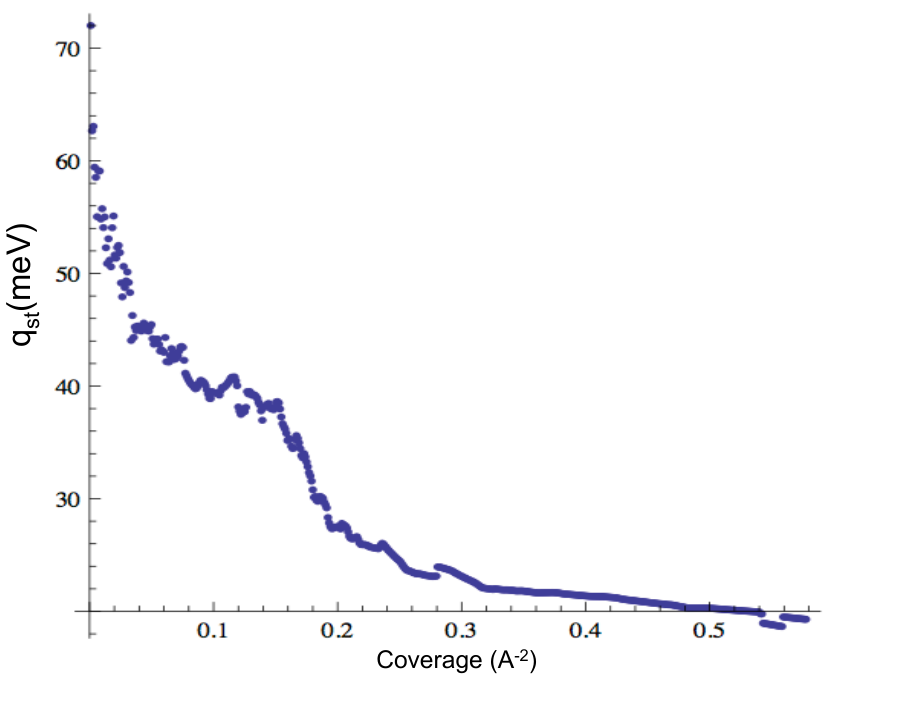
Figure 4. Isosteric heat of adsorption of